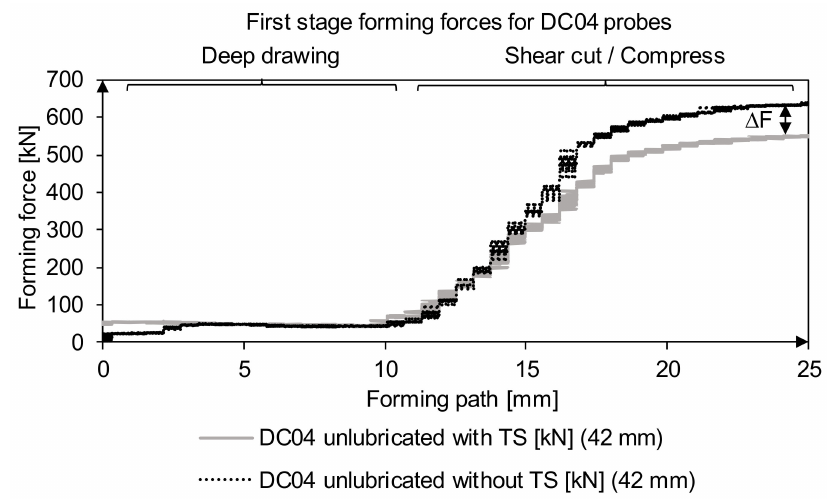
Figure 7. Non-superimposed oscillation forming experiments with tailored surfaces and unstructured tools in the first stage of the SBMF process. The tailored surfaces (TS) are applied as described in Figure